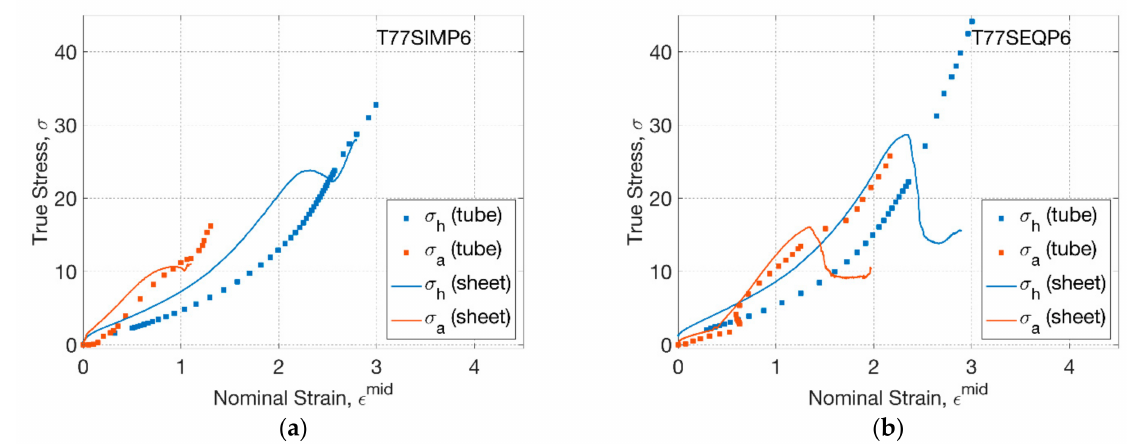
Figure 6. Stress–strain relationship of tubes and sheets: ( a ) T77SIMP6, ( b ) T77SEQP6.